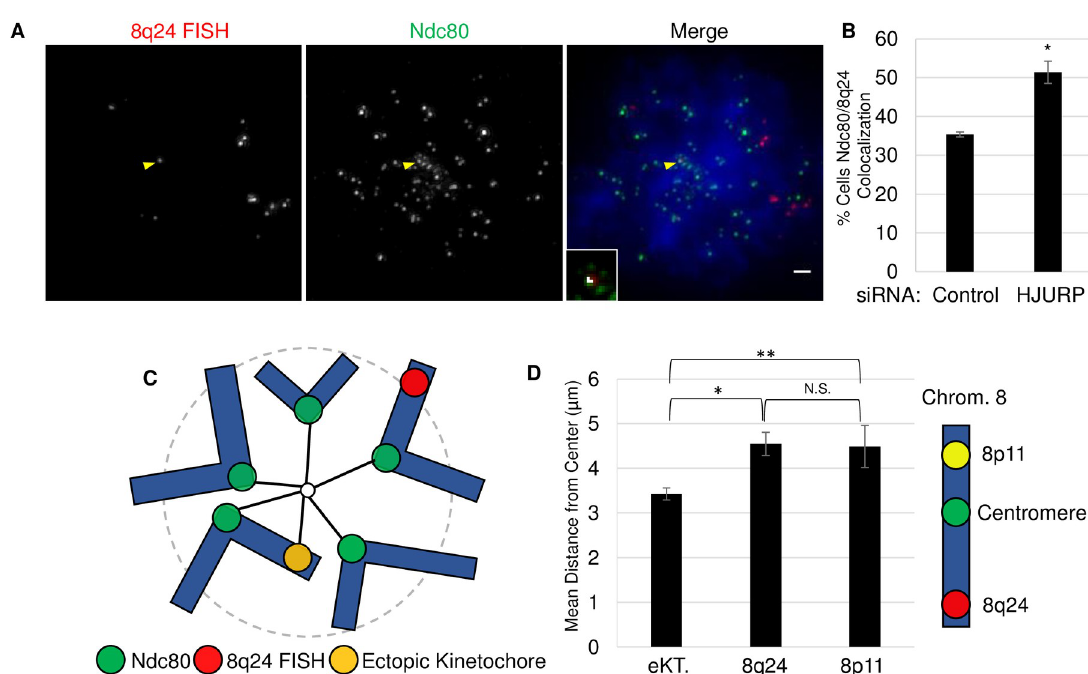
Fig 4. CENP-A mislocalization promotes ectopic kinetochore formation at 8q24. A.) Image showing monastrol treated cell. FISH for the 8q24 locus and IF for the Ndc80 protein was performed on SW480 cells. DAPI in blue. Yellow arrowheads indicate colocalization. Inset shows automated co-localization analysis performed using Image J; white is indicative of co-localization. Scale bar indicates 1 μ m. B.) Graph showing the results of 72 hour knockdown. Percentage indicates mitotic cells with colocalization of Ndc80/8q24. Error indicates SEM from 3 experiments n > 100 cells. ( � indicates P-value < 0.01, Students t-test). C.) Figure illustrating chromosome arrangement in monastrol treated cells. D.) Results from experiments in which cells were treated with monastrol cytospun onto a slide. Measurements were then performed by drawing an elipse around the area containing centromeres then the distance between the center of the elipse and either 8p11 loci or 8q24 loci with (eKT) and without (8q24) Ndc80 recruitment was measured. ( � indicates p-value < 0.01, �� p-value < 0.05, Students t-test) SEM from triplicate experiments N = 54 cells. Diagram of chromosome 8 indicates position of FISH probes